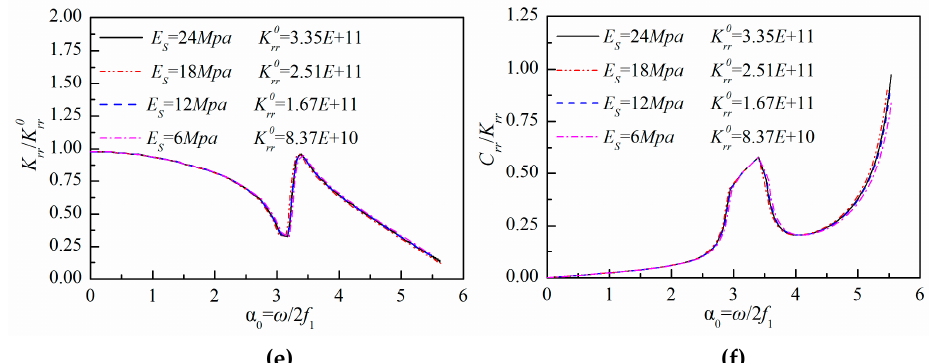
Figure 13. Variation of three dynamic impedance coefficients with respect to the dimensionless frequency under the effect of the relative homogeneous soil stiffness: ( a ) Horizontal stiffness coefficient; ( b ) horizontal damping coefficient; ( c ) coupling stiffness coefficient; ( d ) coupling damping coefficient; ( e ) rocking stiffness coefficient; ( f ) rocking damping coefficient.